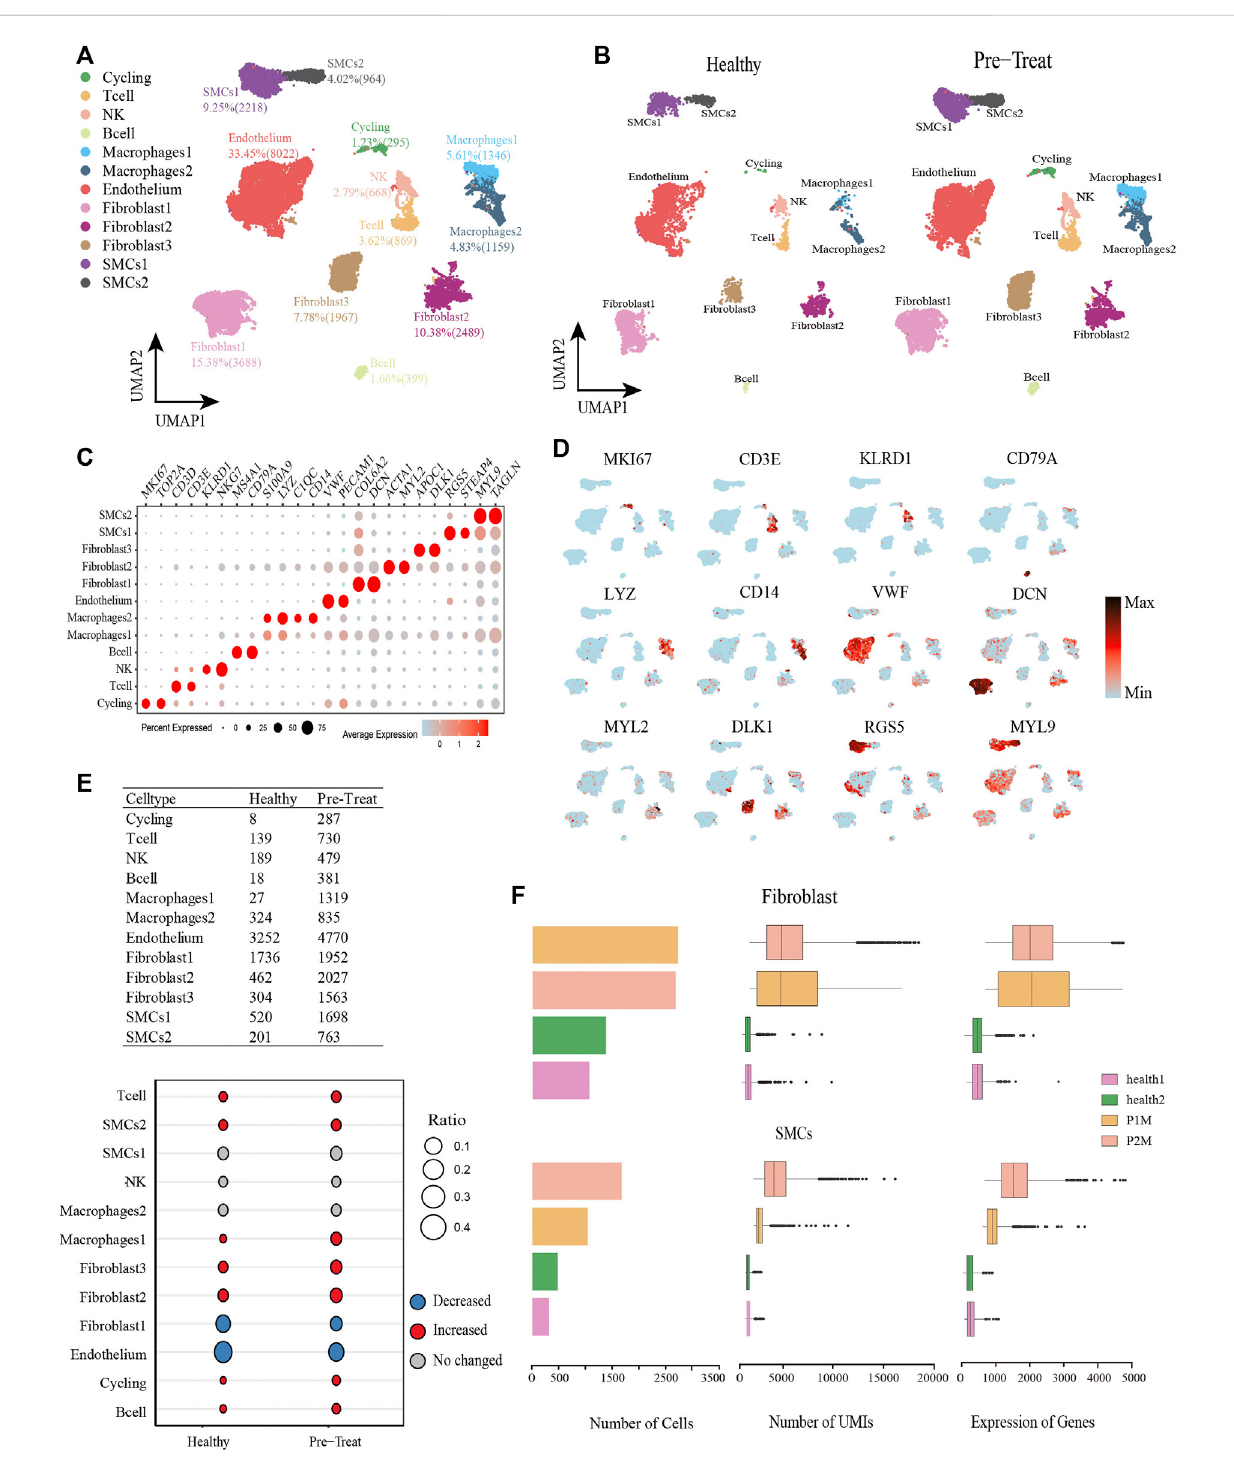
FIGURE 2 Global transcriptomic pro fi les of muscle cells from control and JDM patients reveals their cellular subpopulations as determined by ScRNA-seq. (A) Uniform Manifold Approximation and Projection (UMAP) plots of single-cell transcriptomic pro fi les showing cell types of muscle cells from all the samples. Each dot represents a cell, which is colored according to cell type. (B) UMAP plots of single-cell transcriptomic pro fi les showing cell types of muscle cells from healthy and pre-treatment groups, respectively. Each dot represents a cell, which is colored according to cell type. (C) Bubble chart of markers for each identi fi ed cell type. (D) Feature plots of expressiondistributionfor representative genes for each cell type in muscle. Expression levels for each cell are color-coded and overlaid into UMAP plot. (E) Heterogeneity of cell type composition in healthy control and groups. The table shows the number of each cell type in each group (up); and the bubble chart represents the changes in the cell ratio of cell types between the pre- treatmentandhealthycontrolgroupsinmuscle(down). (F) Thenumberofcells,andboxplotsofthenumberofUMIsandgenes(withtheboxplotcenter, box, whiskers, and points corresponding to the median, interquartile range, 1.5× interquartile range, and outliers, respectively) of SMCs and fi broblasts in each sample of